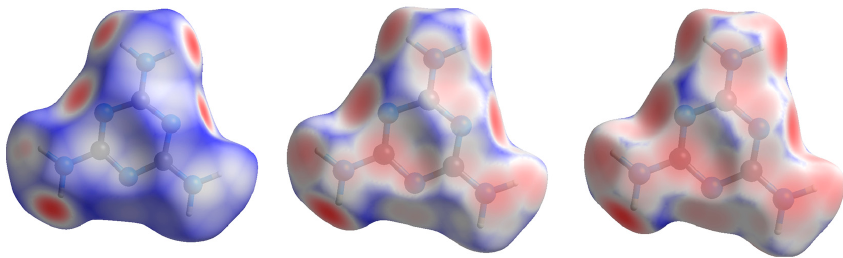
Figure 8. Hirshfeld surfaces displaying d norm at 0.96(5), 17.10(5), and 36.21(5) GPa. As pressure increases, intermolecular contacts are induced, primarily as new hydrogen bonds.